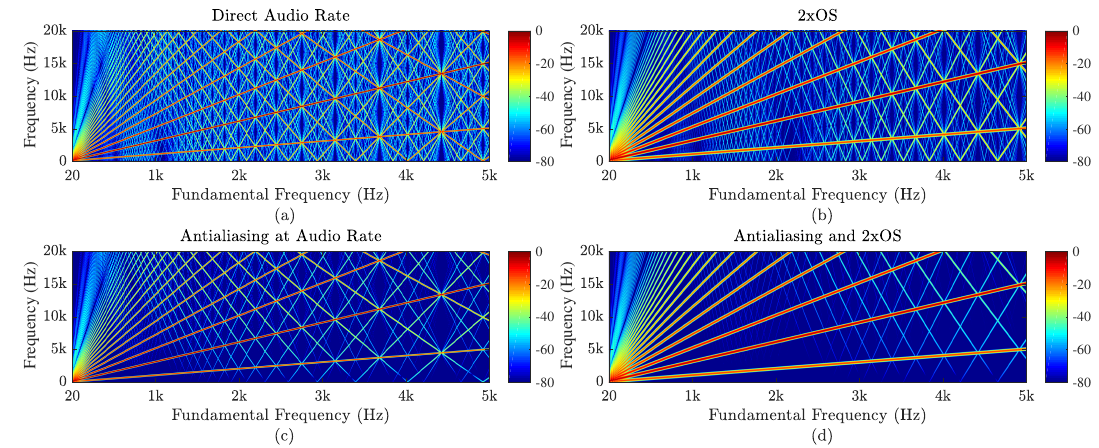
Figure 13. Spectrogram for a 1V linear sweep from 20Hz–5kHz processed with the proposed Lockhart wavefolder ( R L = 50k Ω ) model: ( a ) at audio rate; ( b ) using two times oversampling; ( c ) with antialiasing at audio rate; and ( d ) with antialiasing and oversampling by two.